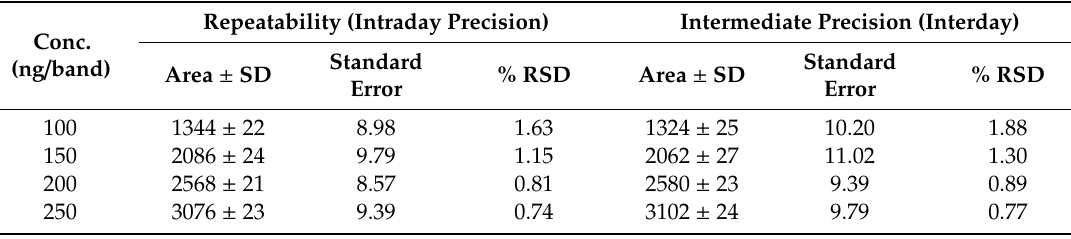
Table 3. Precision analysis of a green RP-HPTLC method (mean ± SD; n = 6).